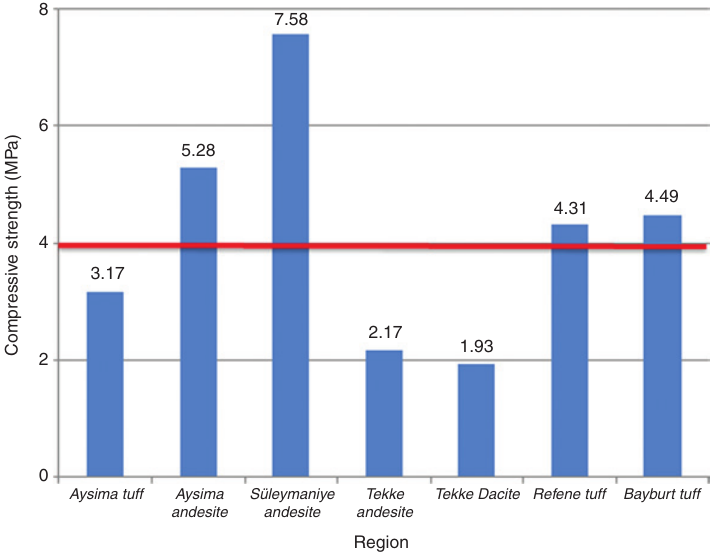
Figure 3 Compressive strength values of the samples at the end of 7 days and limit value according to TS25.